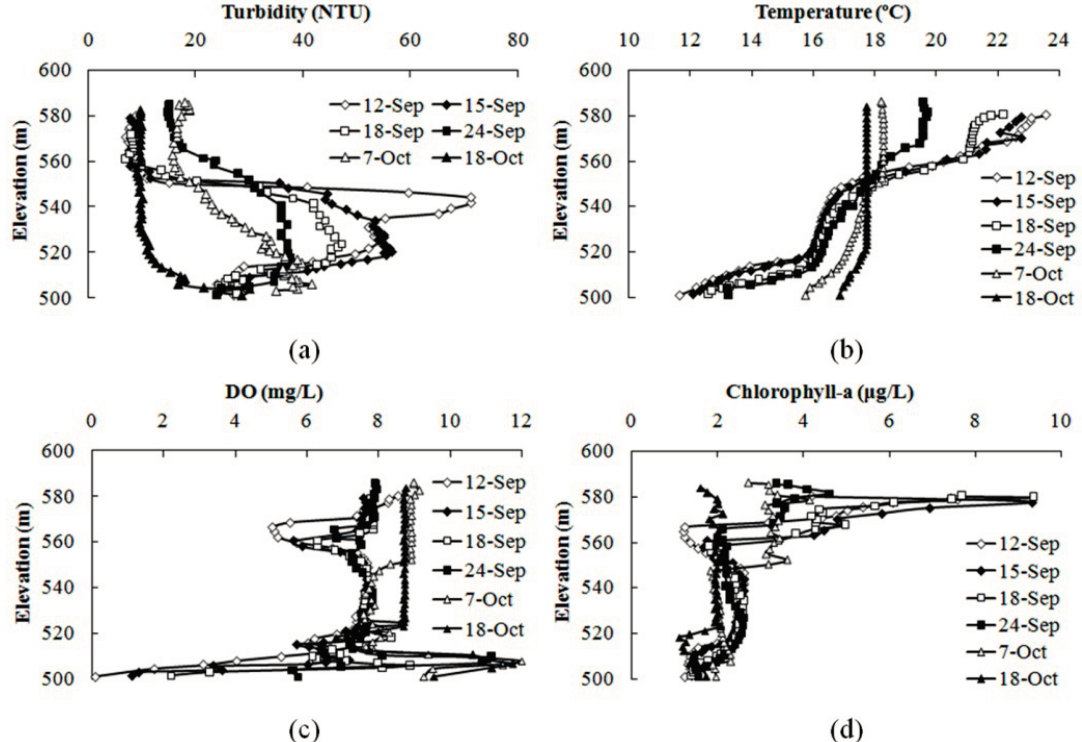
Figure 8. Vertical variation in turbidity ( a ), temperature ( b ), DO ( c ), and chlorophyll-a ( d ) in the Heihe Reservoir during the WLAs operation